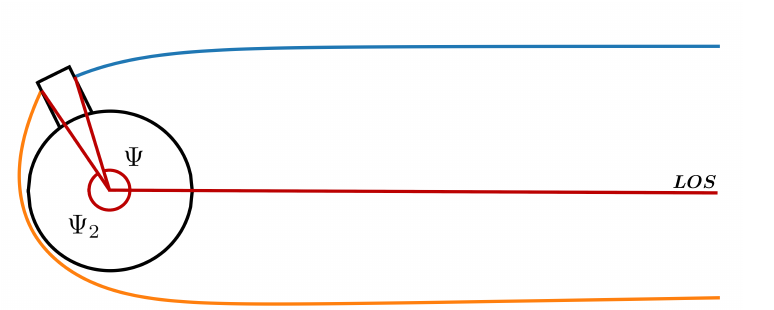
Figure 3. Two possible trajectories for the fan beam of an accretion column. The blue one shows a trajectory in which the periastron is the emitting point. The yellow trajectory has a periastron along the way, and the emitting point is positioned on the back of the column.